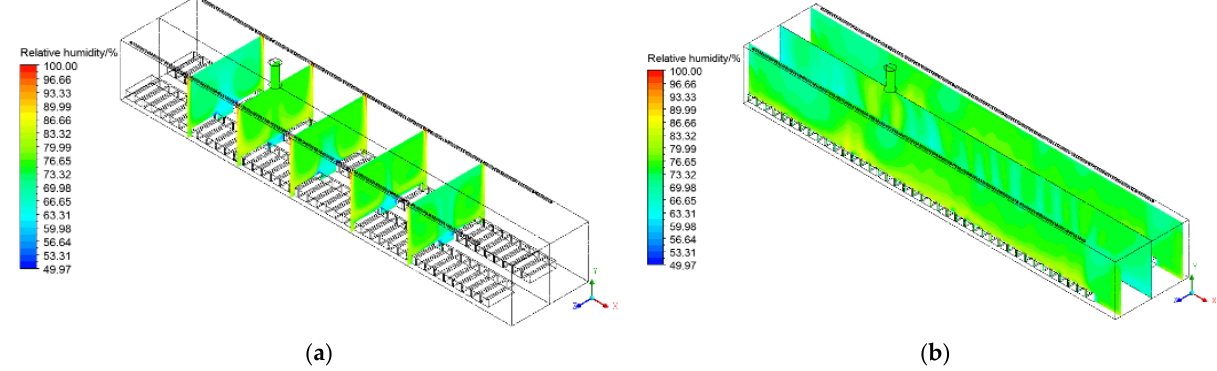
Figure 7. Humidity distribution in different ( a ) longitudinal and ( b ) horizontal sections.